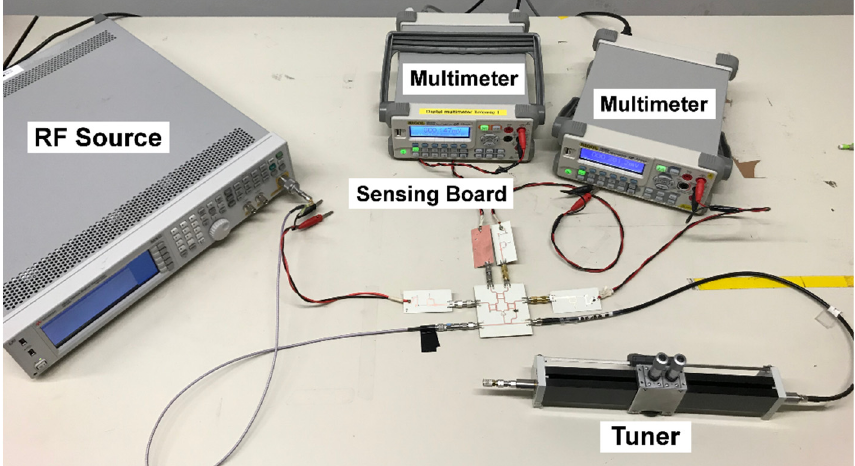
Figure 12. Measurement setup for the validation of the sensing board with single-tone measurements.